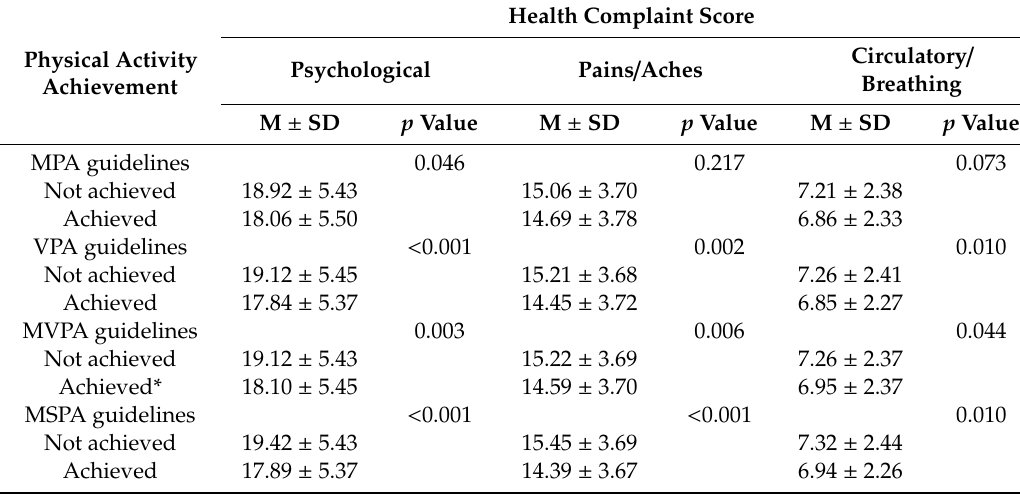
Table 5. Bivariate relationships between four types of physical activity guidelines achievement and health complaints among undergraduates, University of Turku, Finland.